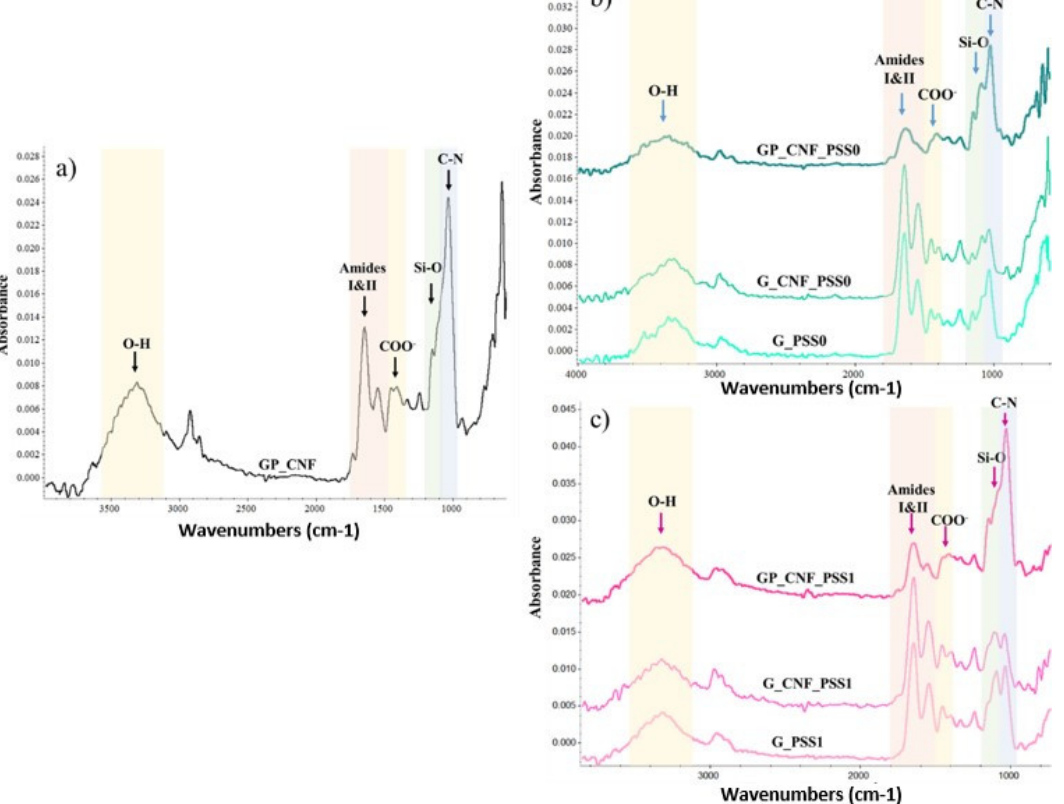
Figure 1. FTIR spectra of ( a ) GP_CNF; ( b ) POSS0-reinforced and ( c ) POSS1-reinforced hydrogels.